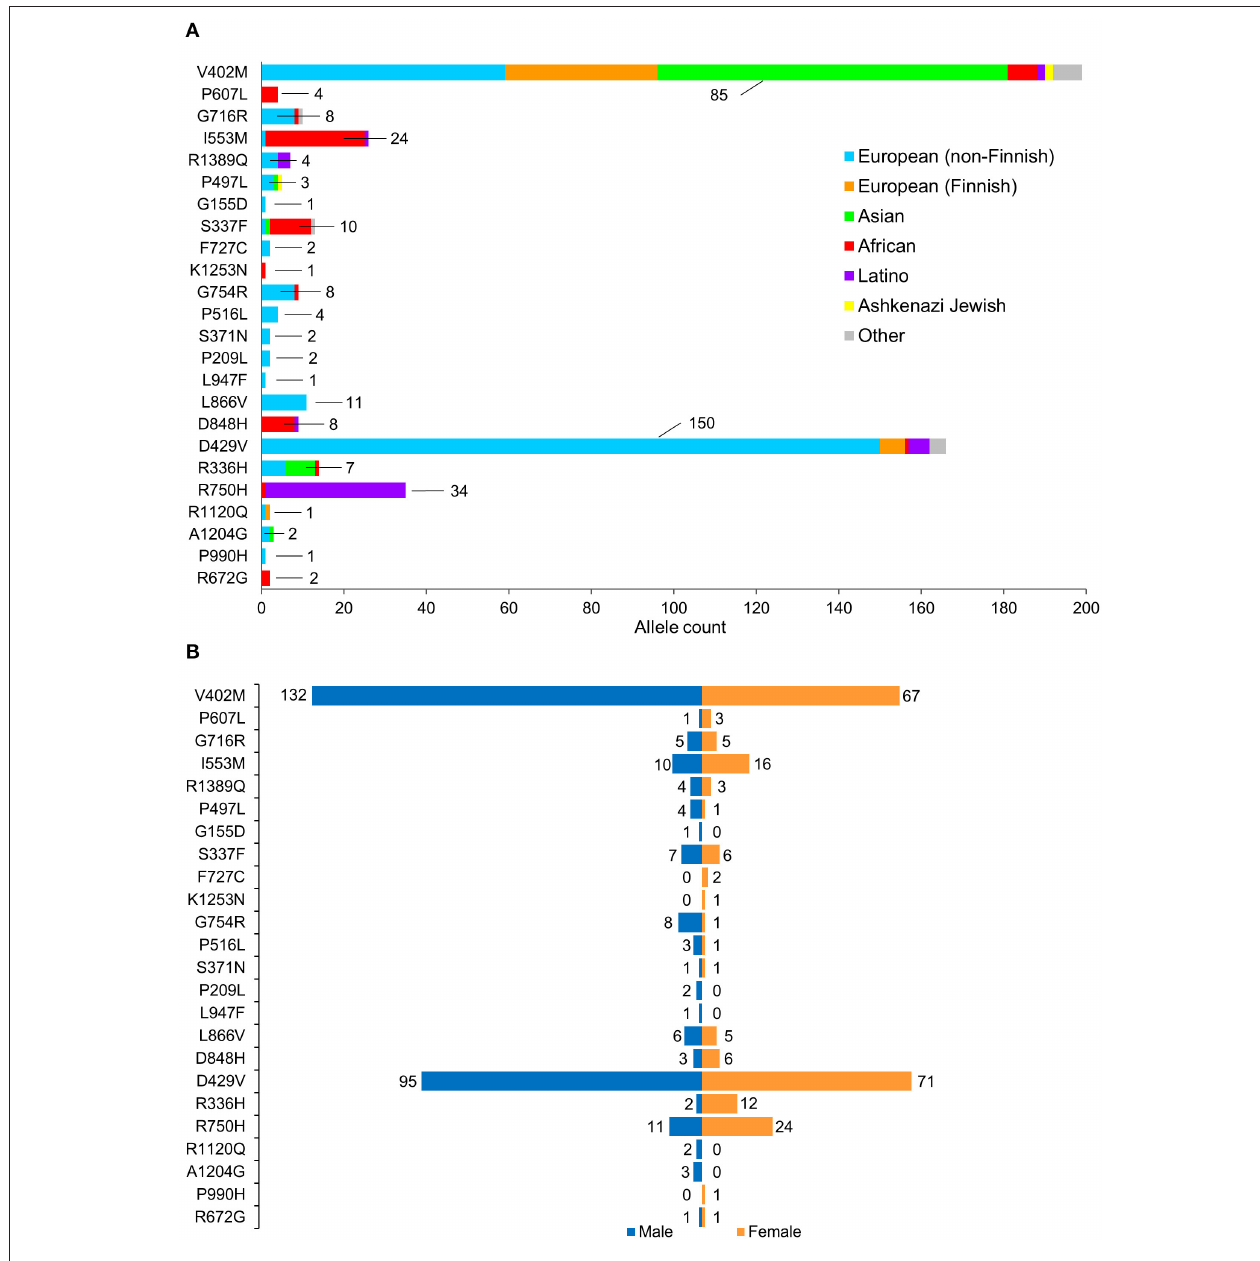
FIGURE 2 | Population characteristics of cohorts associated with prioritized NUP155 variants. (A) Occurrence of the NUP155 prioritized variants cohort in European (non-Finnish), European (Finnish), Asian (including East Asians), African, Latino and Ashkenazi Jewish populations based on gnomAD database information. “Other” ethnicity includes individuals that did not classify into given gnomAD designations. Highlighted here are the numbers of the most overrepresented ethnic population for each variant. Total allele counts based on population characteristics is shown in Supplemental Table 2 . (B) Breakdown of the NUP155 prioritized variants occurrence according to sex, where males are shown in blue and females in